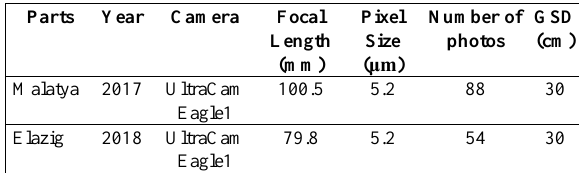
Figure 1. The location of study area with the landslide inventory and the DEM.